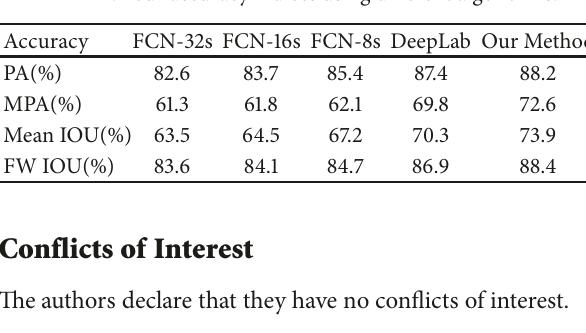
Table 2: Four accuracy indices using different